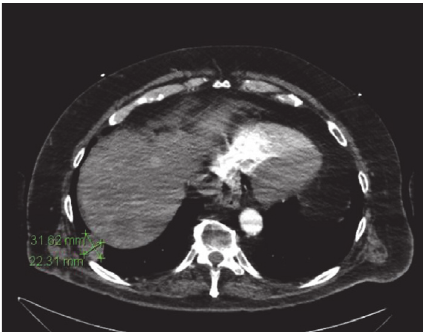
Figure 3: PET scan identifies intensely hypermetabolic nodular lesion on the left lateral chest wall inferior to left axilla, highly suspicious for malignancy (max SUV